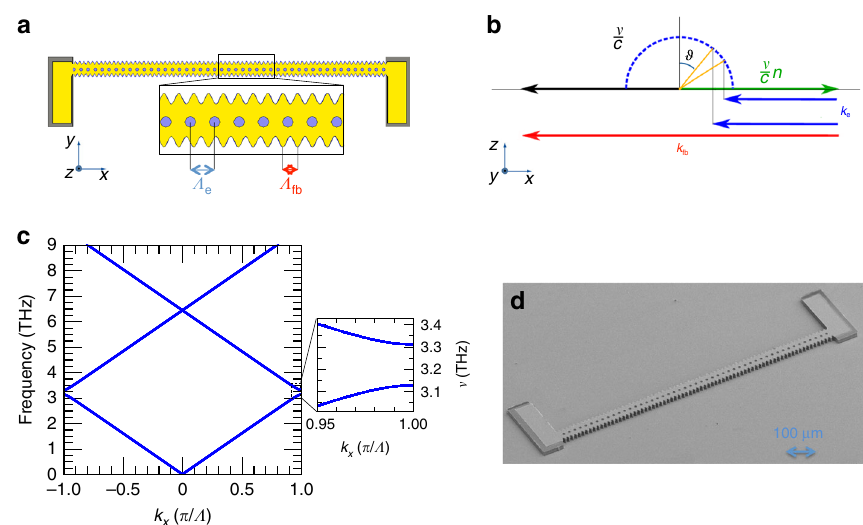
Fig. 1 Resonator design and rationale. a Schematic diagrams of the laterally corrugated wire laser with a periodic (period Λ fb = 13.6 µ m) sinusoidal corrugation. The double-metal cavity comprises a central corrugated region, with two Cr pads at the ends of the resonator cavity being used to suppress unwanted electromagnetic modes. The inset shows the top metal contact (yellow) patterned with etched air holes (blue) with a periodicity Λ e , which de fi ne the extraction wavevector k e . Λ e was varied in the range 19.4 – 23.7 µ m, around the ideal theoretical value of 21.2 µ m for an expected emission frequency of 3.1 THz. The thin Cr absorbing layer is marked in gray. b Light cone diagram. The feedback wavevector k fb (red line) and the extraction one k e (blue line) are indicated on the graph, together with the backward-propagating (black line) and forward-propagating (green line) laser cavity wavevectors. For a given frequency ν , different η parameters provide distinct extraction wavevectors, which determine the light extraction ef fi ciency and emission angle ϑ into free space (dotted blue line). Here n is the refractive index and c is the light speed in vacuum. c One-dimensional photonic band structure, computed on the feedback geometry only, based on a sinusoidal spatial pro fi le of the dielectric function, and for a ridge having average width of 40 µ m, a lateral corrugation length of Λ fb = 13.6 µ m, and a corrugation amplitude of 10 µ m on each side of the mesa. d Scanning electron microscope image of a fabricated device, with hole radius, r = 5 µ m, Λ e = 22.4 µ m ( η = 0.95), and average width of 40 µ